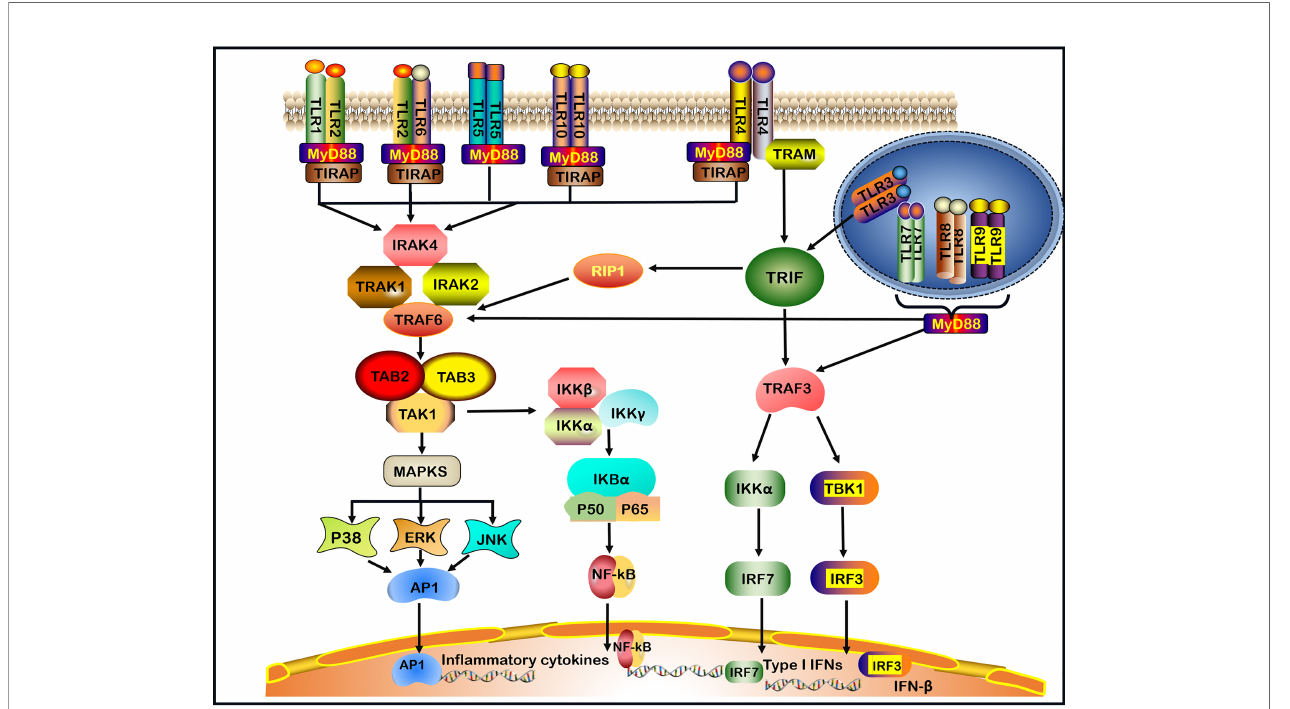
FIGURE 1 | TLRs signaling pathways. TLRs (Toll-like receptors) recognize invading microbes and activate signaling pathways, which regulate immune and in fl ammatory responses. TLR1, TLR2, TLR5, TLR6, and TLR10 are located on the cell surface.TLR3, TLR7, TLR8, and TLR9 are located on the intracellular endosome membranes. All TLRs, with the exception of TLR3, by the (MyD88)- dependent signaling pathway. In addition, TLR4 signaling takes place in both MyD88-dependent and the MyD88- independent signaling pathway. In MyD88-dependent signaling pathway, the leucine-rich repeats (LRR) region of TLR binds to ligands resulting in the formation of TLRs heterodimer, such as TLR2-TLR1/TLR2-TLR6/TLR7-TLR8 heterodimer or TLR4/TLR9 homodimer, which induces the recruitment of the TIR domain-containing adaptor protein (TIRAP)/MyD88/interleukin-1 receptor-associated kinase-1 (IRAK-1)/IRAK2/IRAK-4 complex. After that, the complex continues to activate tumor necrosis factor receptor-associated factor 6 (TRAF6) and subsequent transforming growth factor-beta-activated kinase 1 (TAK1), TAK1-Binding Protein-1(TAB1) and TAK1-Binding Protein-2(TAB2), leading to the activation of mitogen-activated protein kinases (MAPKs, including subsequent activation of P38, ERK, and JNK) and nuclear factor-kappa B (NF- k B) signaling pathway, and promoting the production of pro-in fl ammatory cytokines. In the MyD88-independent signaling pathway, the activation of TLR3 or TLR4 can recruit TRIF. In particular, TLR4 requires a TRIF-related adaptor molecule (TRAM) for the activation of TRIF. Then, TRIF activates receptor-interacting protein 1(RIP1) and interacts with TRAF6 to promote subsequent in fl ammation signaling pathways. In addition, TRIF activates TRAF3, which in turn induces the activation of IRF3 and IRF7 to produce IFN- b and Type I IFNs respectively. Finally, TLR7, TLR8, TLR9 activate TRAF3 or TRAF6 and subsequent signaling pathways through the MyD88- dependent